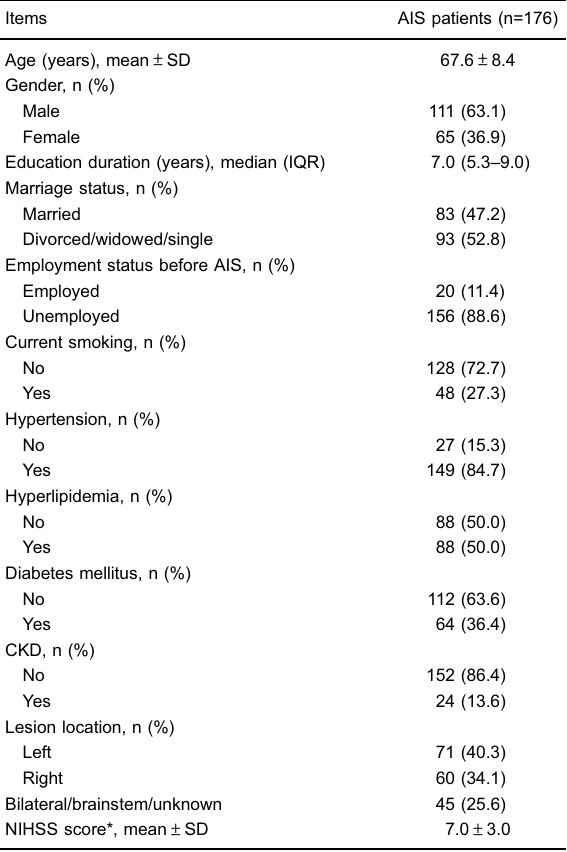
Table 1. Characteristics of acute ischemic stroke (AIS)